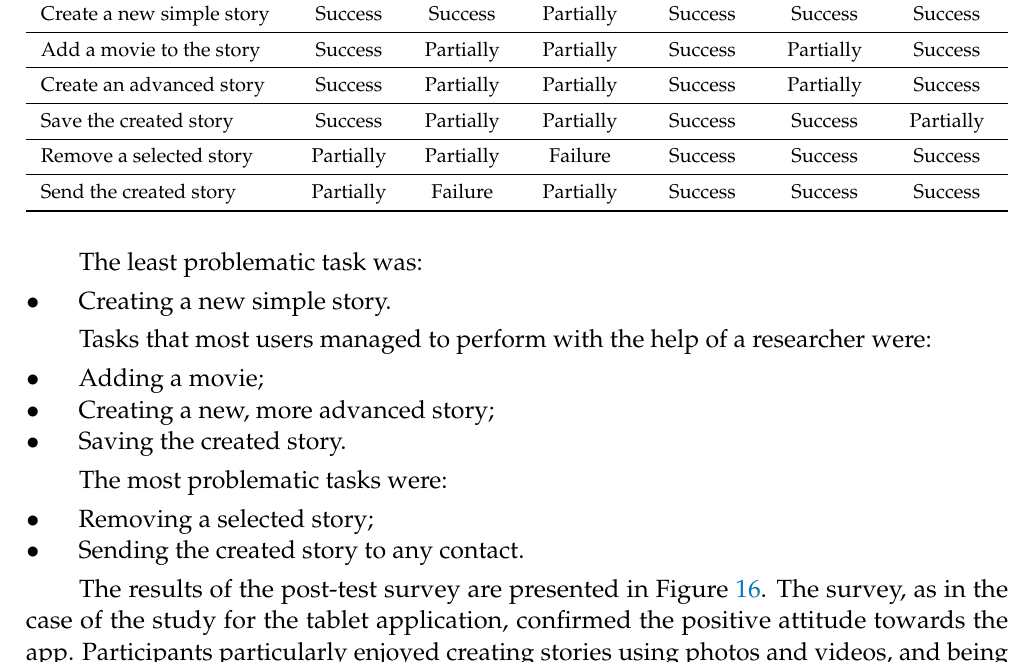
Figure 15. Results of the usability test of the Aphastory app.